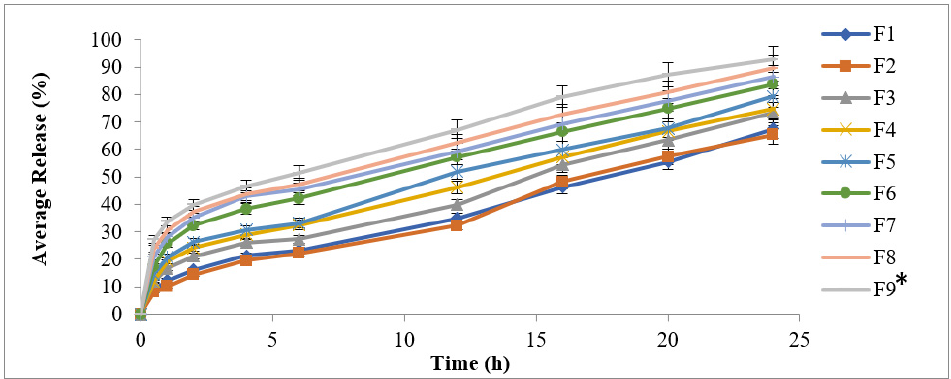
Figure 3. Release profiles of methotrexate from formulated patches (F1–F9). Data are expressed as mean ± SD; n = 3. One-way ANOVA followed by post hoc Tukey test ( p < 0.05), F9 vs.